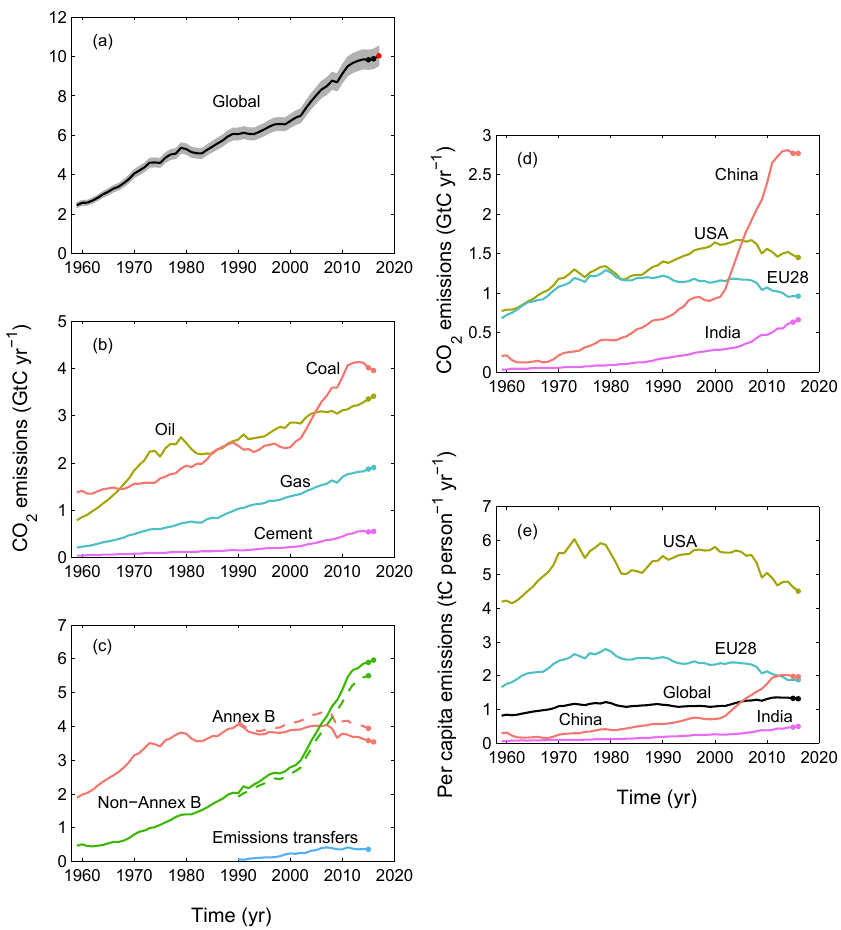
Figure 5. CO 2 emissions from fossil fuels and industry for (a) the globe, including an uncertainty of ± 5% (grey shading), the emissions extrapolated using BP energy statistics (black dots), and the emissions projection for year 2017 based on GDP projection (red dot); (b) global emissions by fuel type, including coal (salmon), oil (olive), gas (turquoise), and cement (purple), and excluding gas flaring which is small (0.6% in 2013); (c) territorial (solid line) and consumption (dashed line) emissions for the countries listed in Annex B of the Kyoto Protocol (salmon lines; mostly advanced economies with emissions limitations) versus non-Annex B countries (green lines) – also shown are the emissions transfer from non-Annex B to Annex B countries (light blue line); (d) territorial CO 2 emissions for the top three country emitters (USA – olive; China – salmon; India – purple) and for the European Union (EU; turquoise for the 28 member states of the EU as of 2012), and (e) per-capita emissions for the top three country emitters and the EU (all colours as in panel d ) and the world (black). In panels (b–e) ; the dots show the data that were extrapolated from BP energy statistics for 2014 and 2015. All time series are in GtCyr − 1 except the per- capita emissions (e) , which are in tonnes of carbon per person per year (tCperson − 1 yr − 1 ). Territorial emissions are primarily from Boden et al. (2017) except national data for the USA and EU28 (the 28 member states of the EU) for 1990–2014, which are reported by the countries to the UNFCCC as detailed in the text; consumption-based emissions are updated from Peters et al. (2011a). See Sect. 2.1.1 for details of the calculations and data